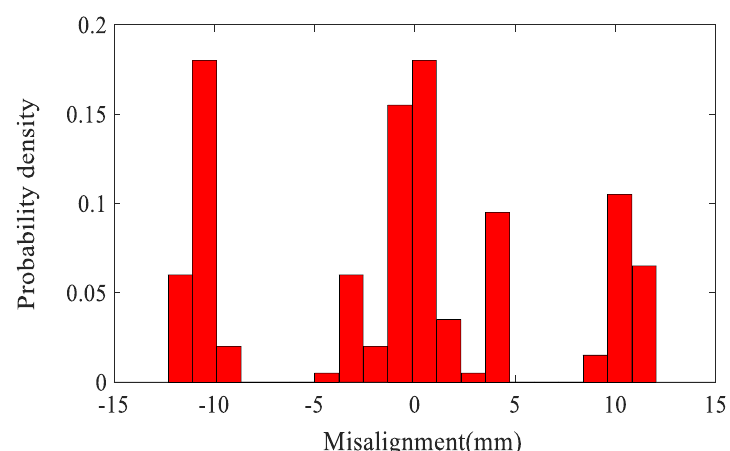
Fig. 5 Probabilistic relations between shear pin’s strength and misalignment